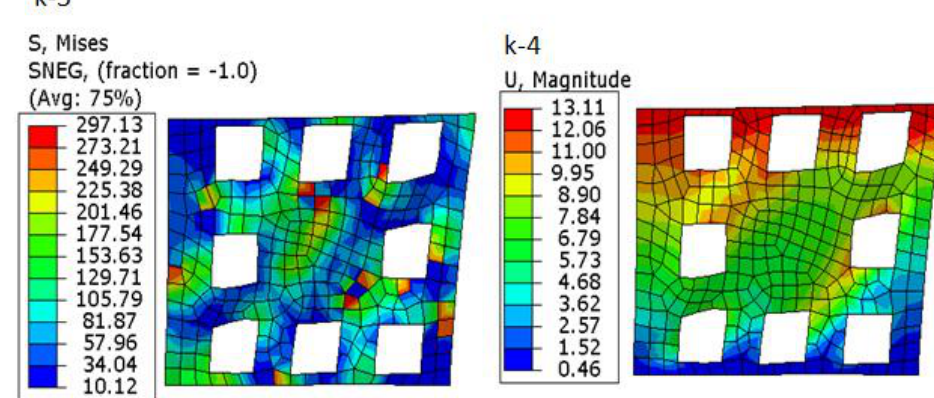
Figure 28. Von Mises stress for shell part (k-1) frame part and (k-2) steel plate.